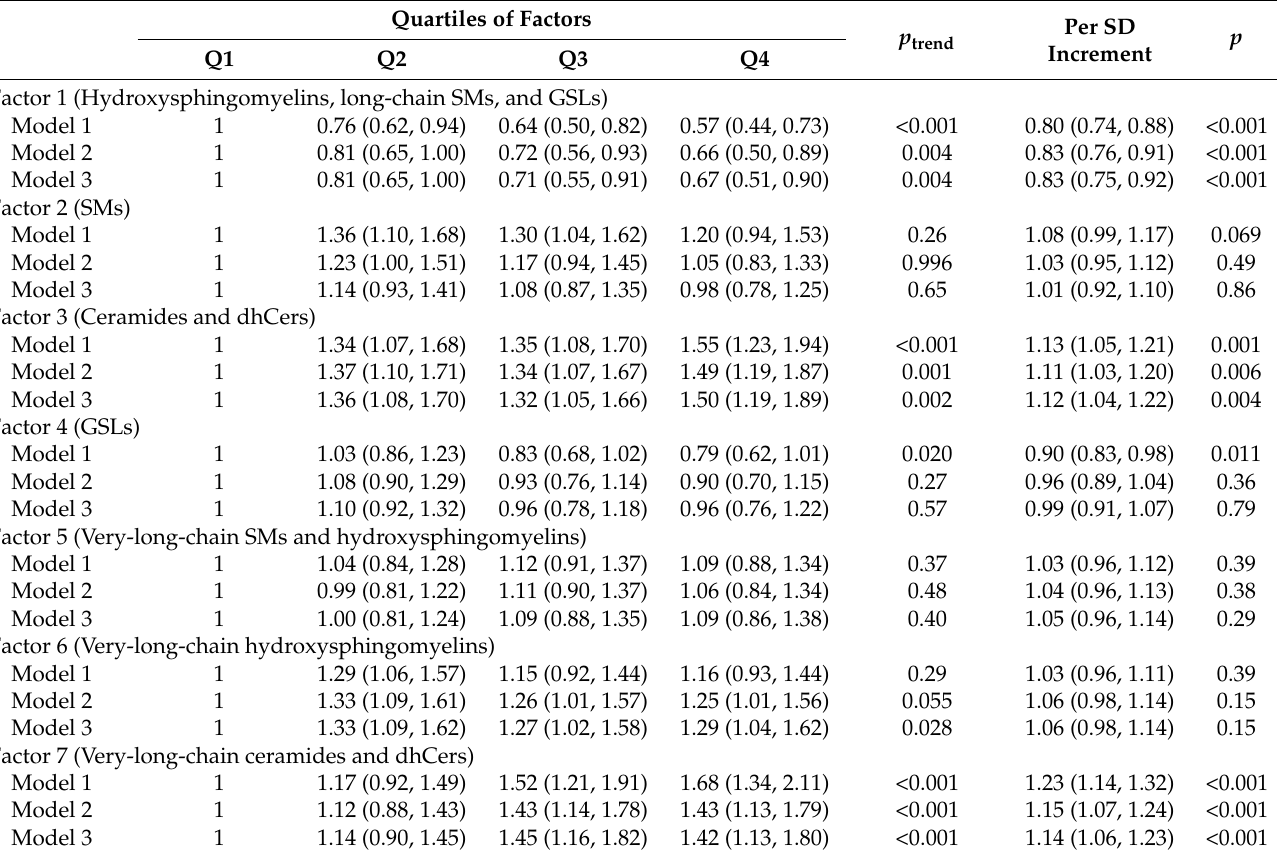
Table 2. Association between baseline sphingolipid factors (PCA extracted) and incident metabolic